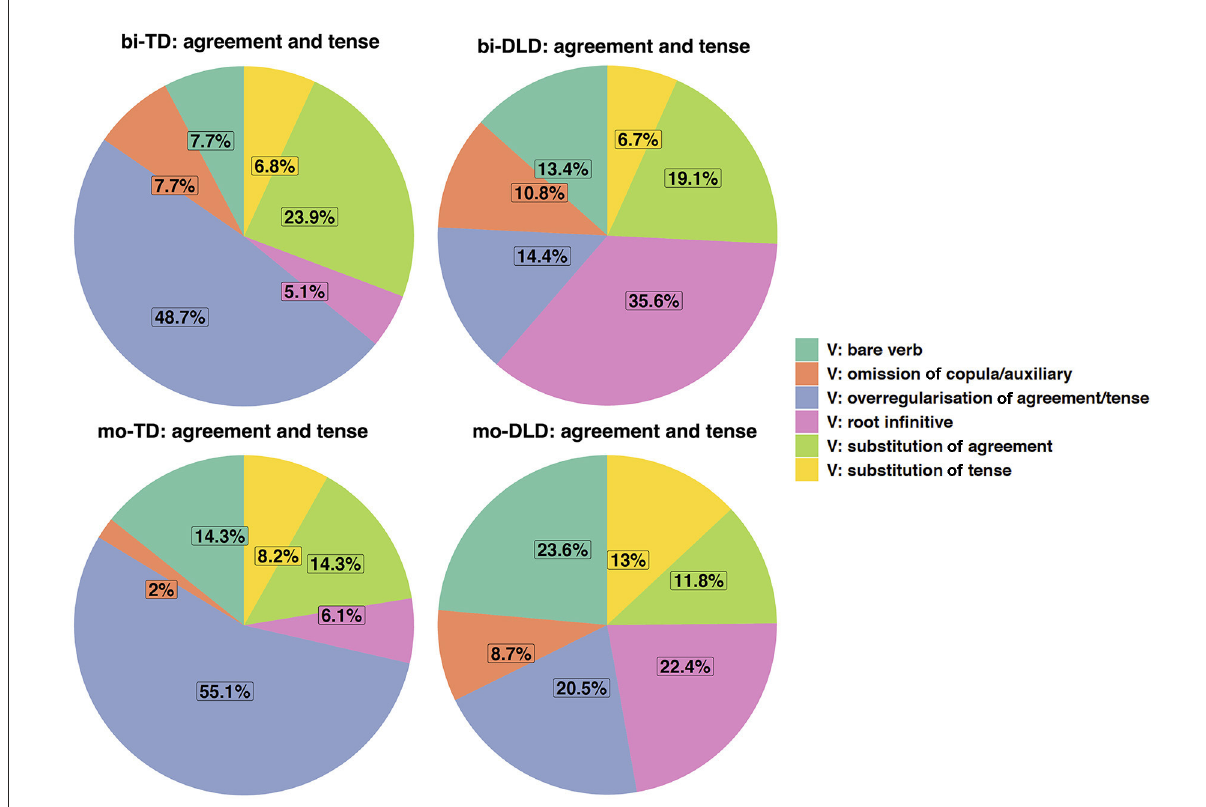
FIGURE7 Distributions of agreement and tense errors in Dutch in the bi-TD, bi-DLD, mo-TD, and mo-DLD